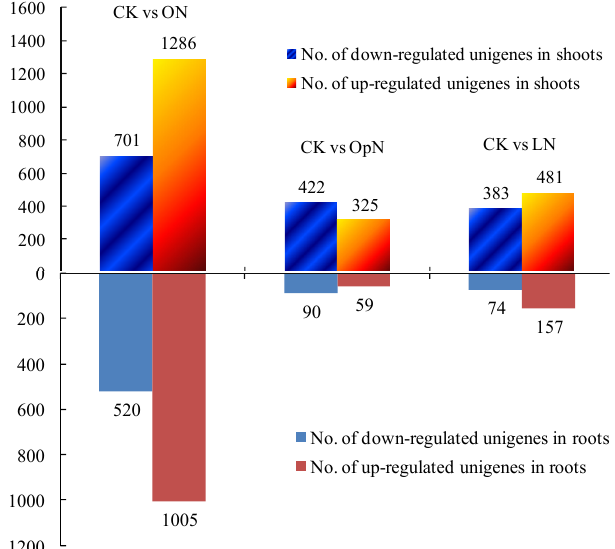
Figure 1. The number of differentially expressed unigenes between the N treatments with the control. The columns above and below the X -axis represent the number of DEGs in shoots and in roots, respectively. The numbers of down- and up-regulated unigenes are indicated using blue and orange columns, respectively. To be considered differentially expressed, transcripts must have FPKM > 0.01, 2-fold or greater difference in expression level between treatments, and p < 0.05. Note: Seedlings were treated with continuous normal N (CK) as control, and were deprived of N for three days and then resupplied with optimal N (OpN), low N (LN), and organic N (ON) treatments for five hours.